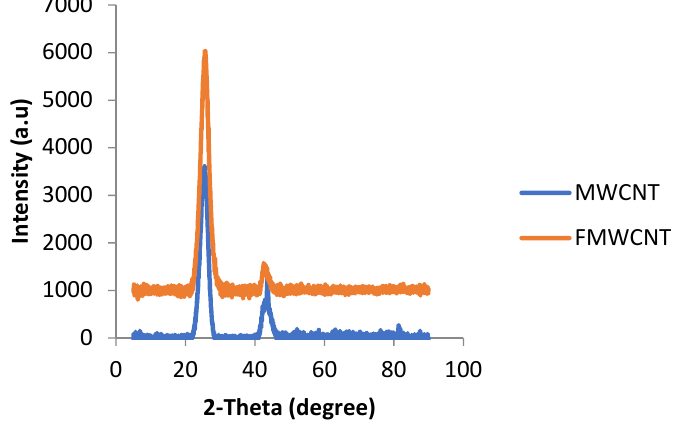
Figure 4. XRD trace of as-received MWCNTs and acid-treated MWCNTs (FMWCNTs).